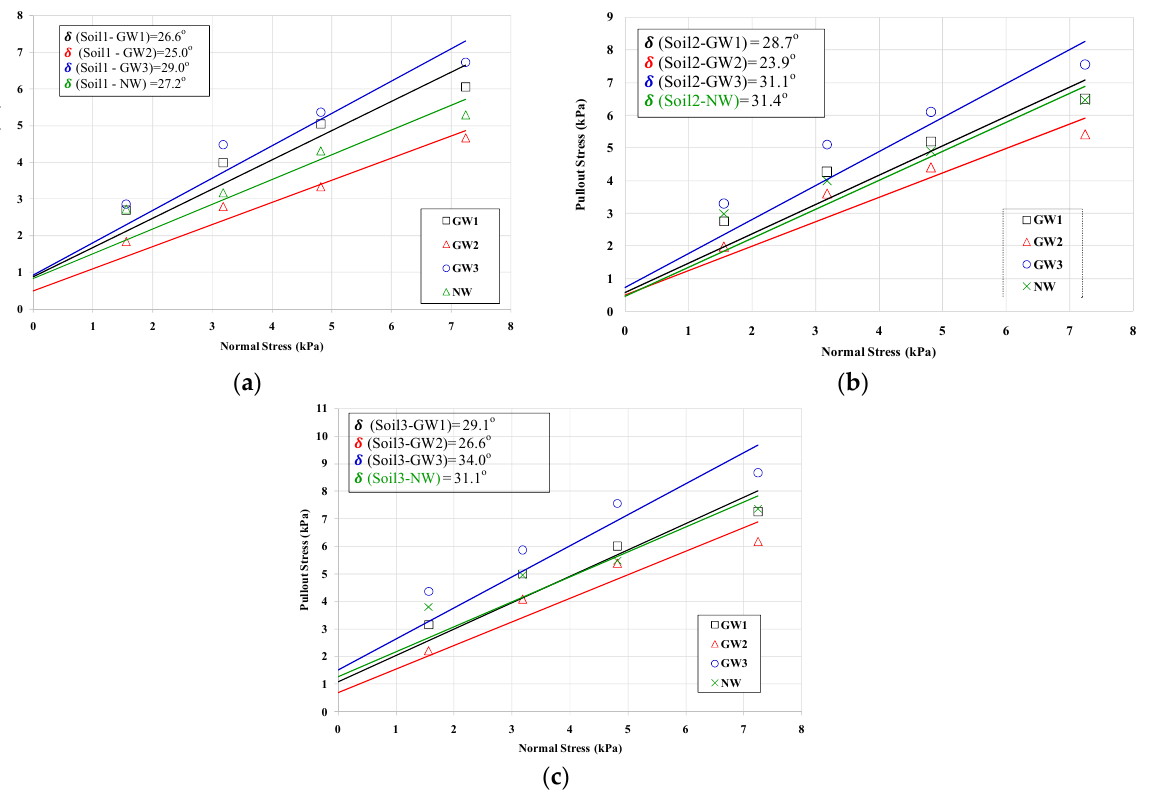
Figure 7. Interface friction angles obtained through vertical pullout with different geosynthetics. ( a ) Geosynthetics~Soil1,( b ) Geosynthetics~Soil2,( c ) Geosynthetics~Soil3 .